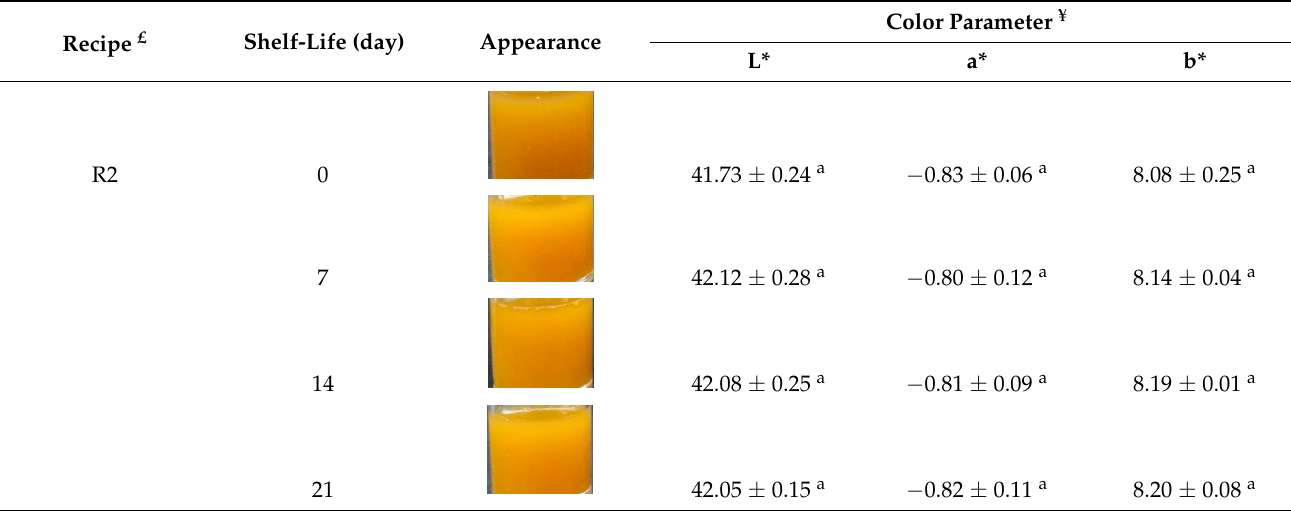
storage for up to 21 days at least (Table 1). Therefore, during refrigerated storage the live probiotic did not alter the color and appearance of the products. Table 1. Appearance and color parameters of fermented whole pineapple juice R2, R2-E1, and R2-E2 during storage at 4 °C for 21 days.